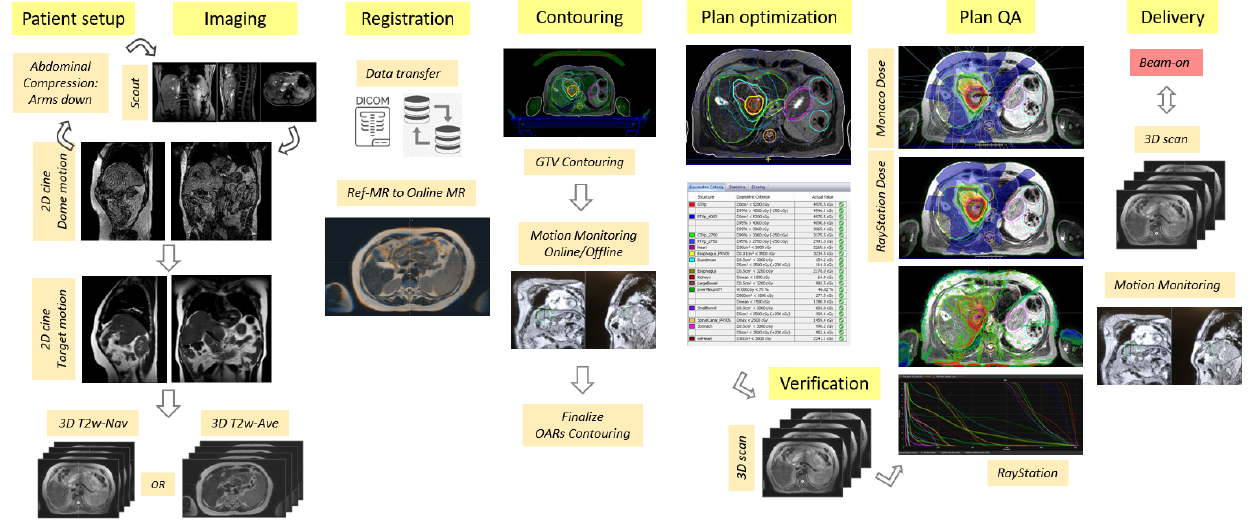
Figure 1. Flow chart highlighting the key processes in the MRI-guided online adaptive workflow based on the adapt-to-shape (ATS) procedure for UGI sites on the Unity MR-Linac system.